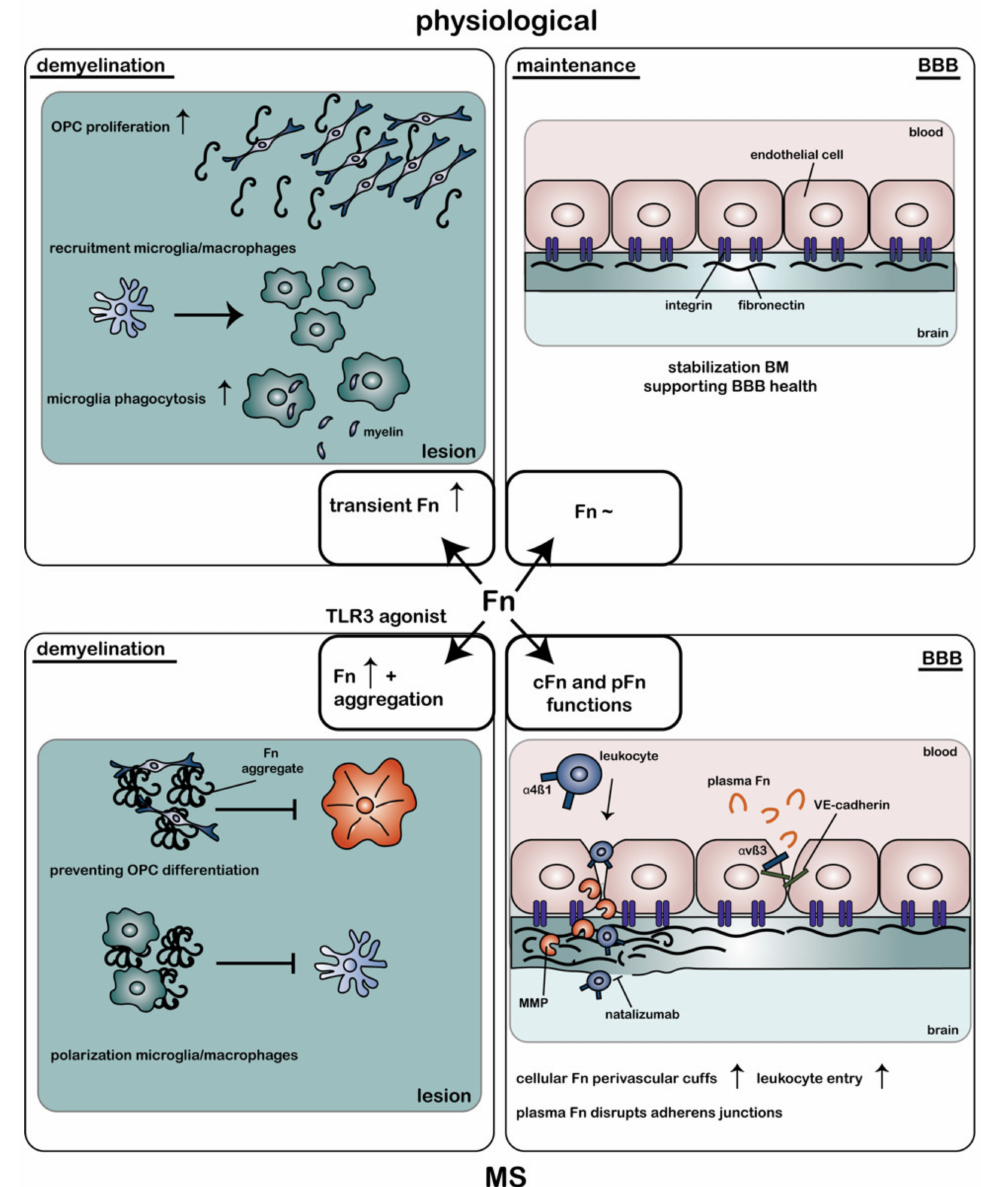
Figure 2. Role of fibronectin in the physiological adult brain, upon demyelination, and in multiple sclerosis. In the non-injured adult brain, fibronectin (Fn) expression is limited to the basement membrane (BM) of the blood–brain barrier (BBB), stabilizing the BM, thereby supporting BBB main- tenance. Upon demyelination in the non-MS brain, Fn expression in the parenchyma is transiently upregulated, which aids (1) oligodendrocyte progenitor cell (OPC) proliferation in the lesioned area, (2) activation and recruitment of pro-inflammatory microglia and macrophages, and (3) myelin debris removal via phagocytosis. Conversely, upon demyelination in the MS brain, Fn expression persists and aggregates under the influence of Toll-like receptor 3 (TLR3) activation. Fn aggregates (1) impede remyelination by preventing OPC differentiation and (2) inhibit the switch from a pro- inflammatory to anti-inflammatory phenotype in microglia and macrophages. In addition, in an MS BM, Fn accumulates in perivascular cuffs near the BBB, which aids leukocyte transmigration across the BBB via integrin α 4 β 1–Fn interaction. Natalizumab, which is a clinically approved MS medication, stops leukocyte entry into the CNS by blocking α 4-integrins. Furthermore, several matrix metalloproteinases (MMPs) are upregulated in MS, which degrade Fn and other BM constituents, contributing to BBB destabilization and leukocyte entry into the brain parenchyma.